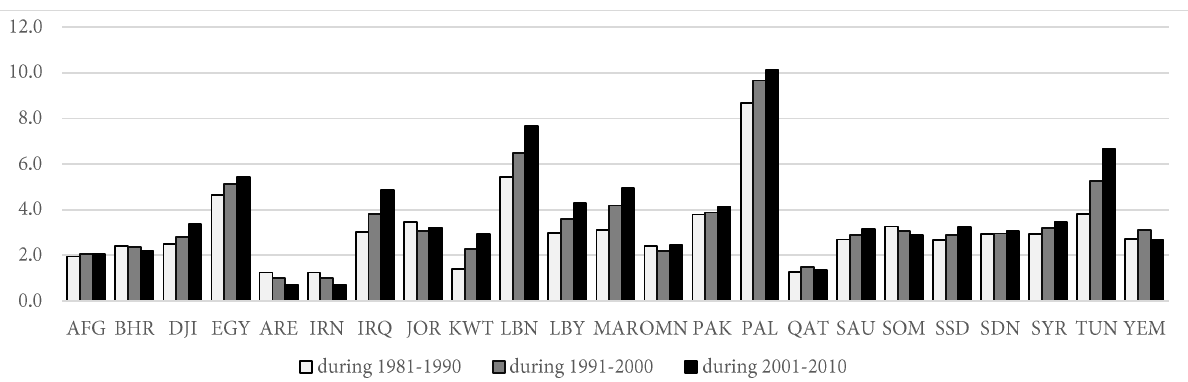
Figure 1. Percentage of 0-14 year old from total population in EMRO countries during the last three decades